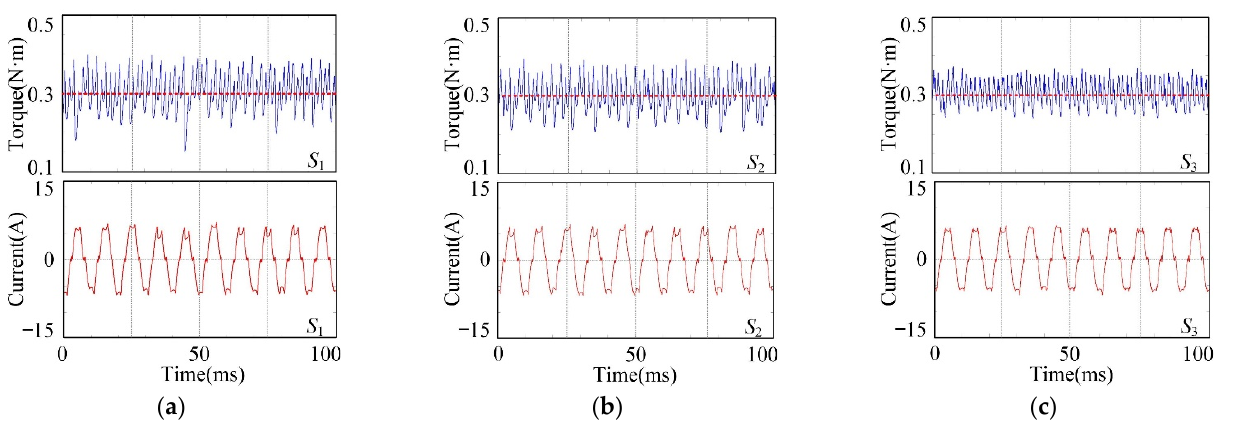
Figure 13. ( a ) Waveforms of torque and phase A current of S 1 under condition 1; ( b ) Waveforms of torque and phase A current of S 2 under condition 1; ( c ) Waveforms of torque and phase A current of S 3 under condition 1.